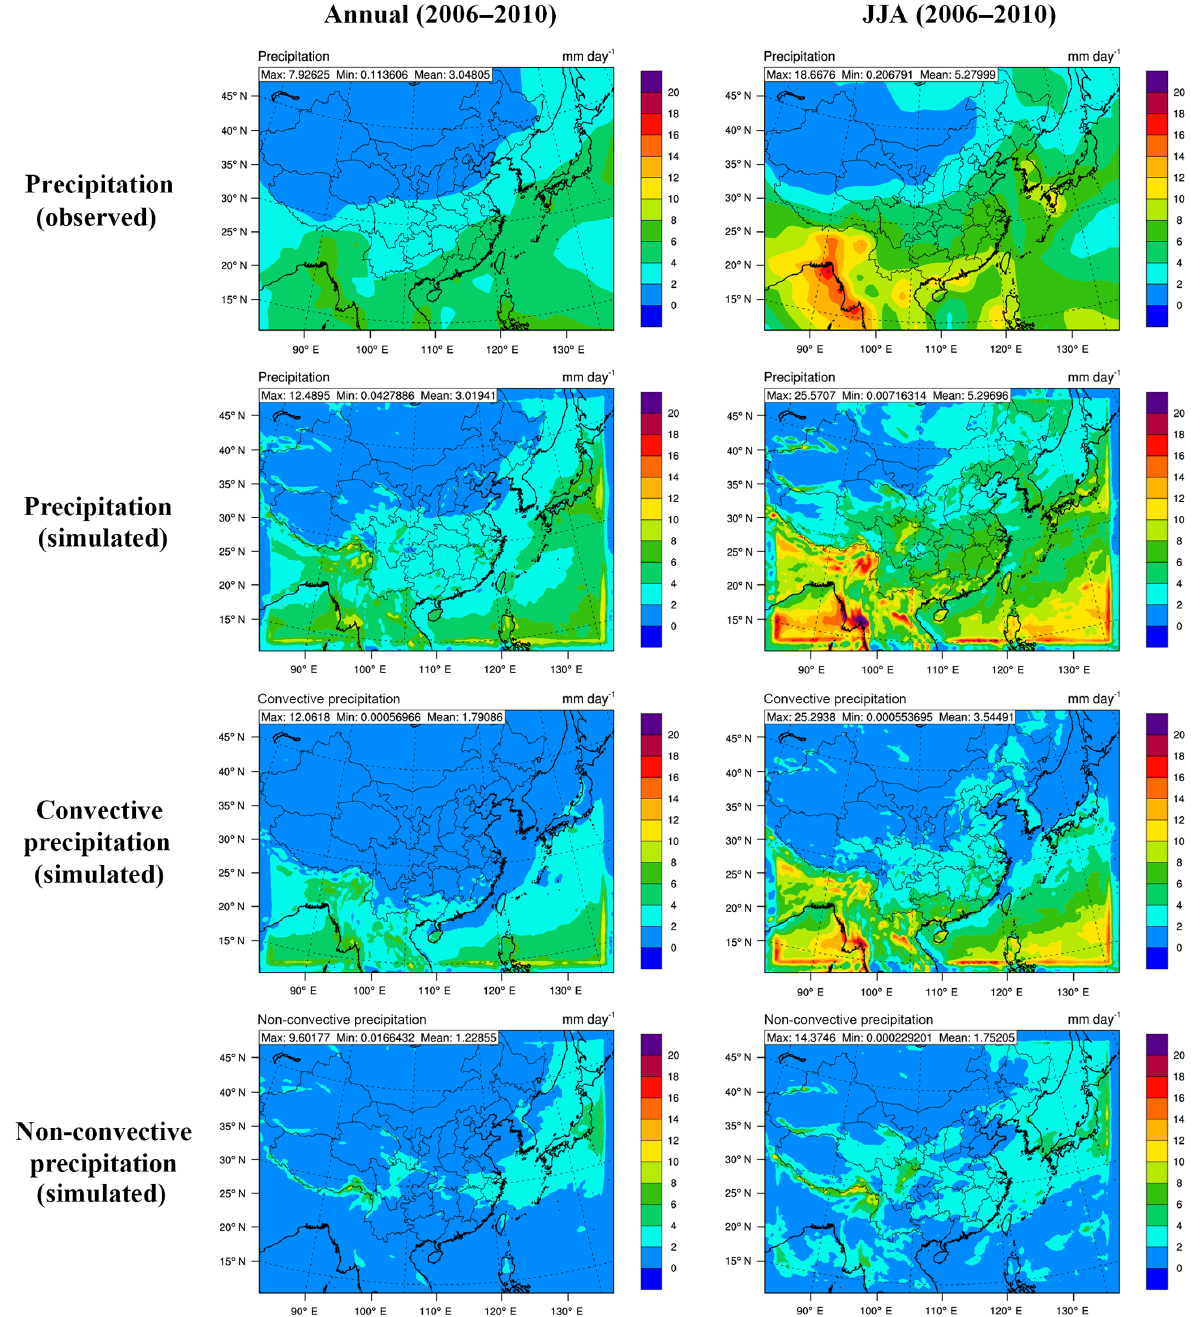
Figure 2. Spatial distribution of satellite-derived precipitation from GPCP, simulated precipitation, convective precipitation, and non- convective precipitation under the climatological application during